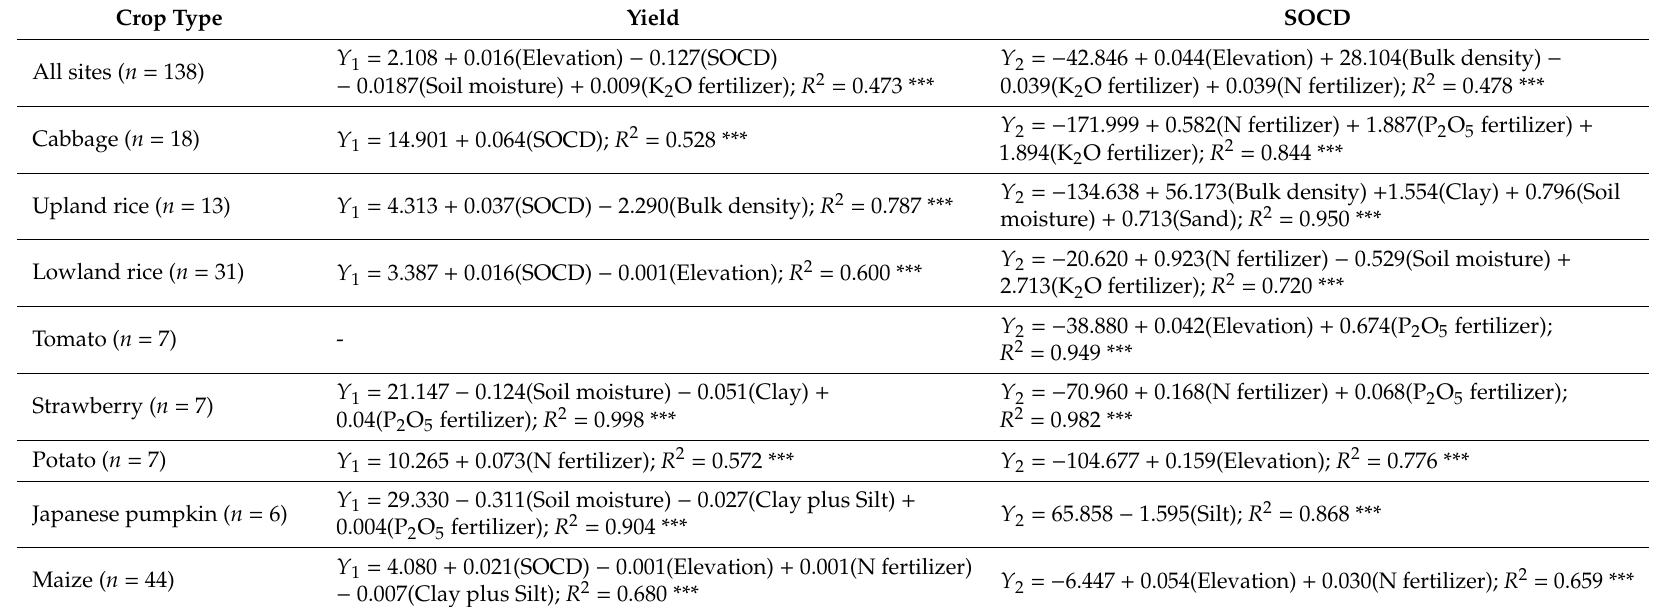
Table 4. Multi-factor regression models used to predict top SOCD and crop yields using N fertilizer, P 2 O 5 fertilizer, K 2 O fertilizer, Elevation, Bulk density, Sand, Silt, Clay, Clay plus Silt, pH, and Soil moisture; where Y 1 is yield and Y 2 is top